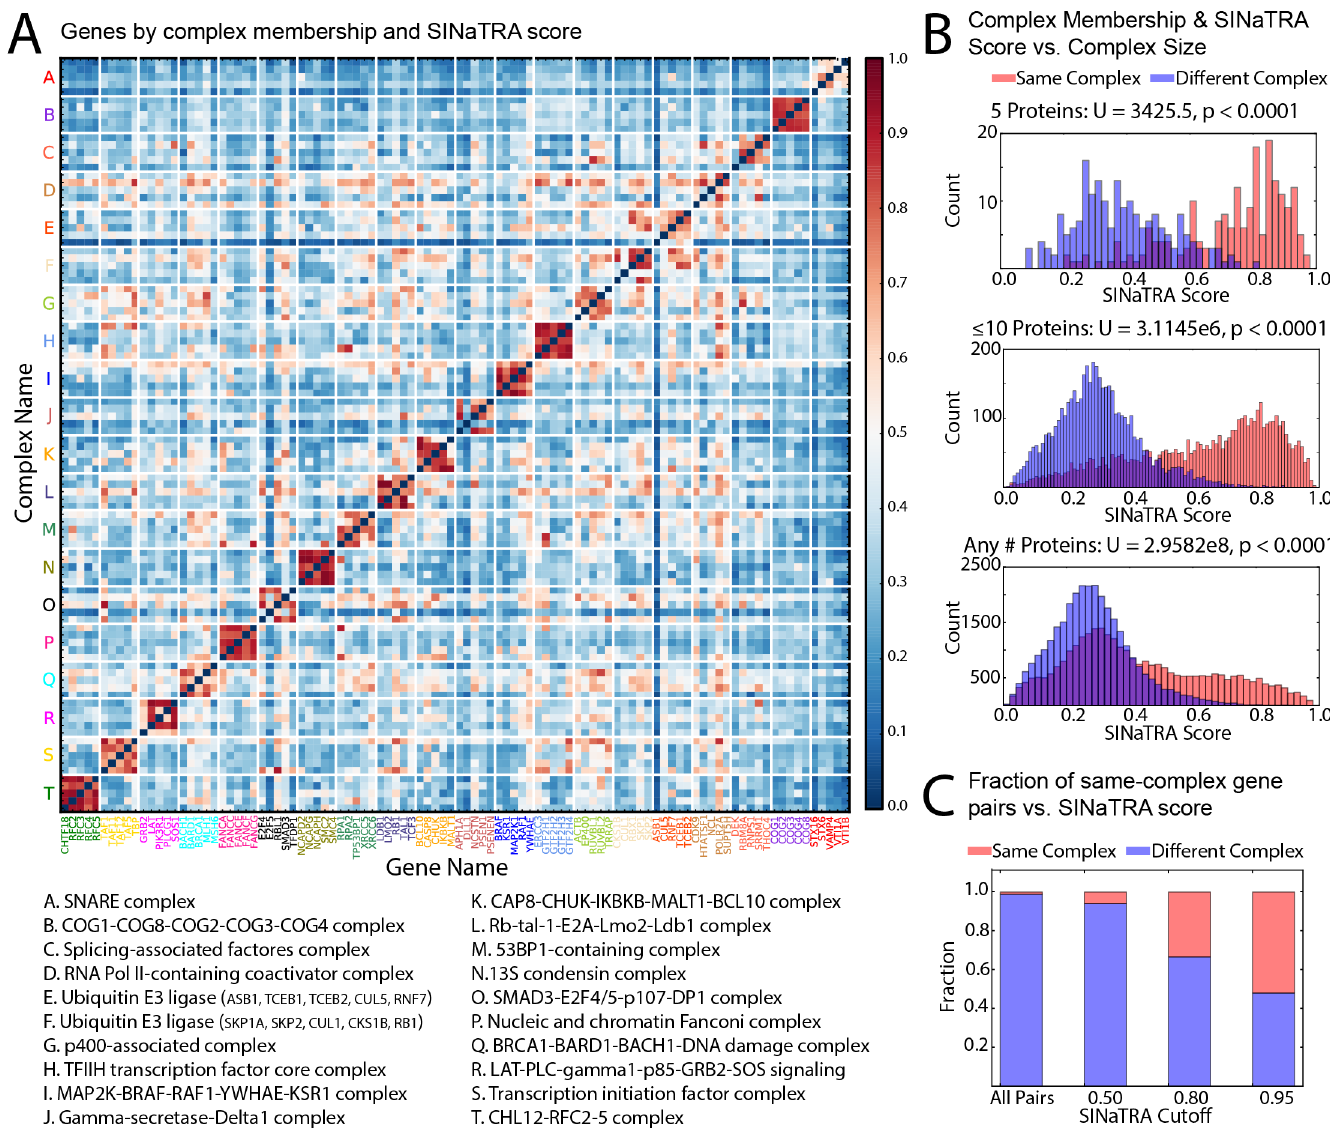
Fig 3. A. We randomly selected 20 mutually exclusive groups of protein complexes that contained exactly five subunits; we mapped the corresponding gene pairs to SINaTRA scores, and plotted a heat map of the results. Data are not clustered and only one randomly sampling was performed. We observed that within-complex gene pairs have significantly higher SINaTRA scores (p < 0.0001, Fisher ’ s exact test). B. We compared the SINaTRA scores of gene pairs with products in the same vs. different complexes for complexes with of 5 protein subunits (top), (cid:3) 10 proteins (middle), and any number (bottom). Although proteins in the same complex are always enriched for higher SINaTRA score, as complex size increases, complex membership becomes less indicative of two genes being SL. C. We compared the fraction of gene pairs with products in the same vs. different complexes for three SINaTRA cutoffs (0.95, 0.80, 0.50) as well as for all gene pairs. A SINaTRA cutoff of 0.95 has approximately half of its pairs associated with the same complex; however, a decrease in the cutoff shifts this balance. This may indicate an increase in different mechanisms of SL in pairs with lower scores. “ All Pairs ” shows the expected proportion of in-complex pairs in our